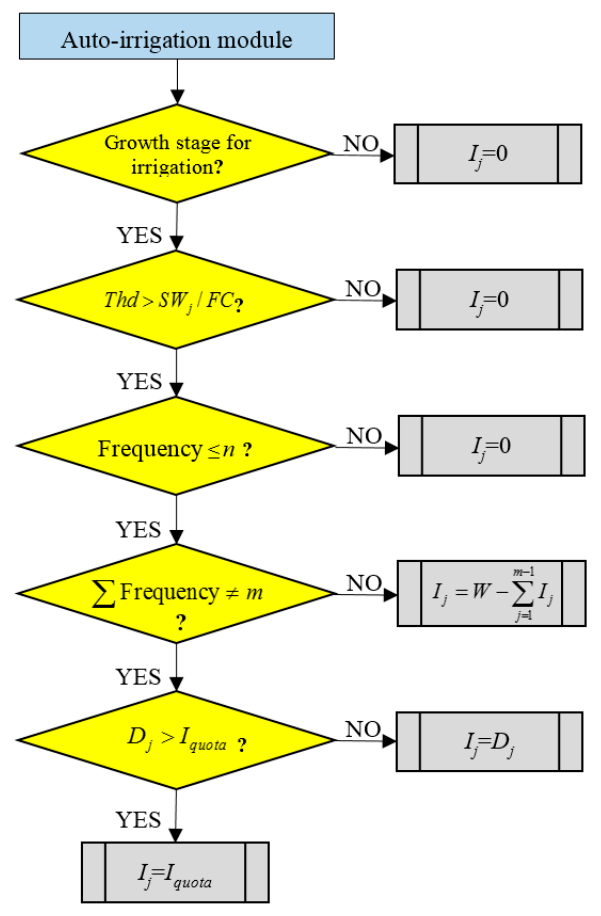
Figure 3. Flow chart of the auto-irrigation procedure.